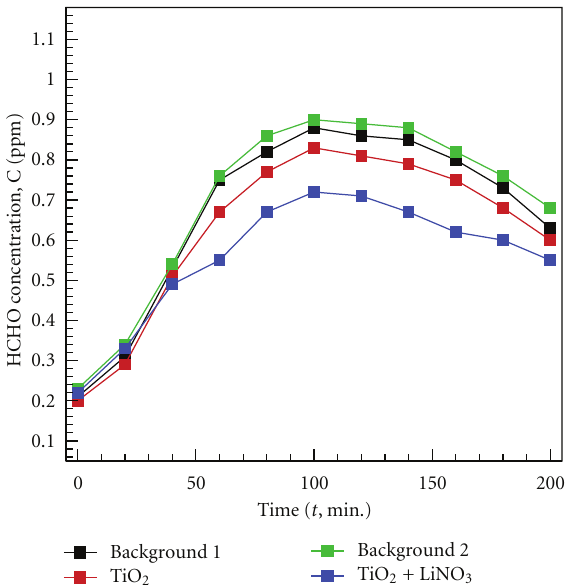
Figure 13: The degradation performance for gaseous formaldehyde under irradiation of visible light lamps at 22 ◦ C.